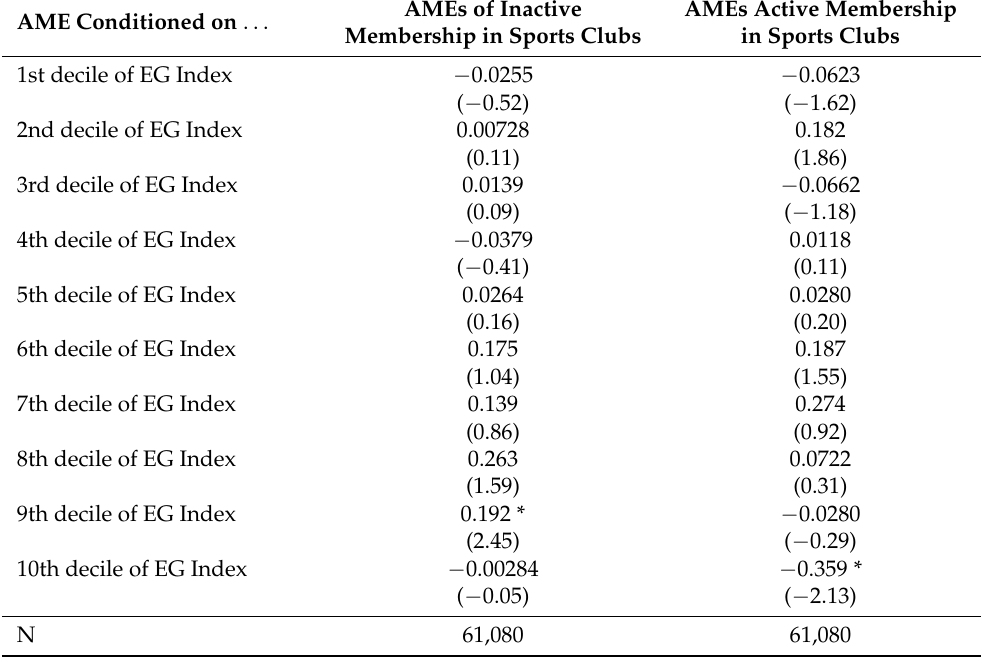
t statistics in parentheses; * p <